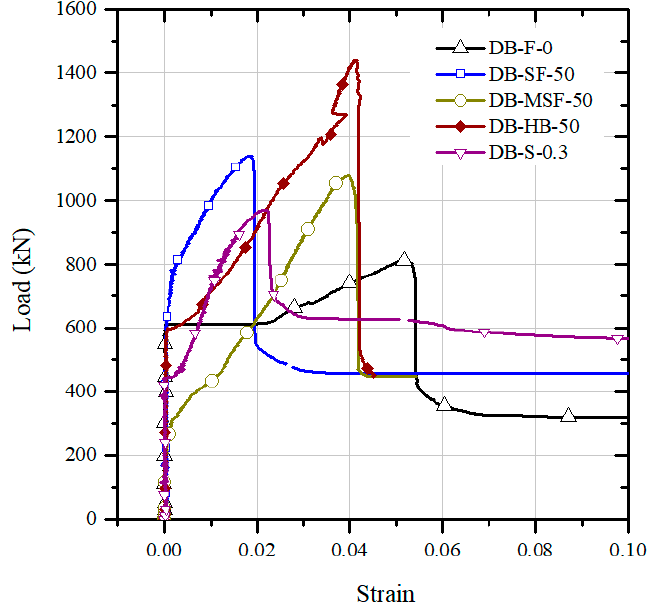
Figure 16. Strain variation normal to critical crack.